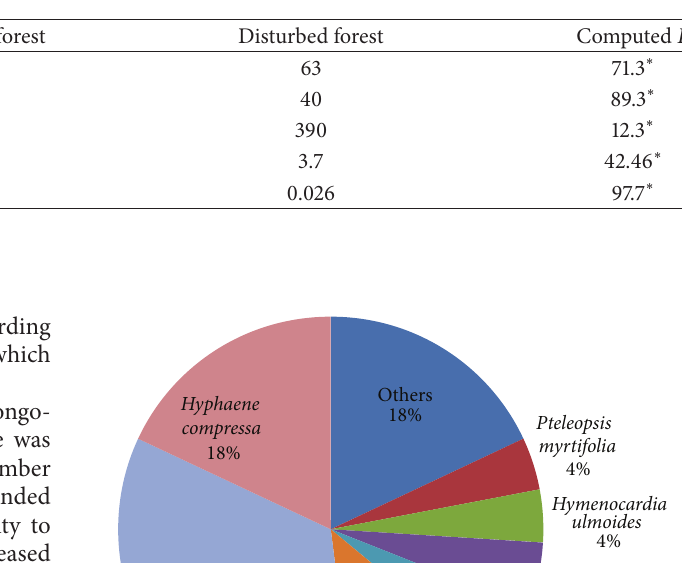
Table 3: Biodiversity characteristics of trees and shrubs in both disturbed and undisturbed forests.